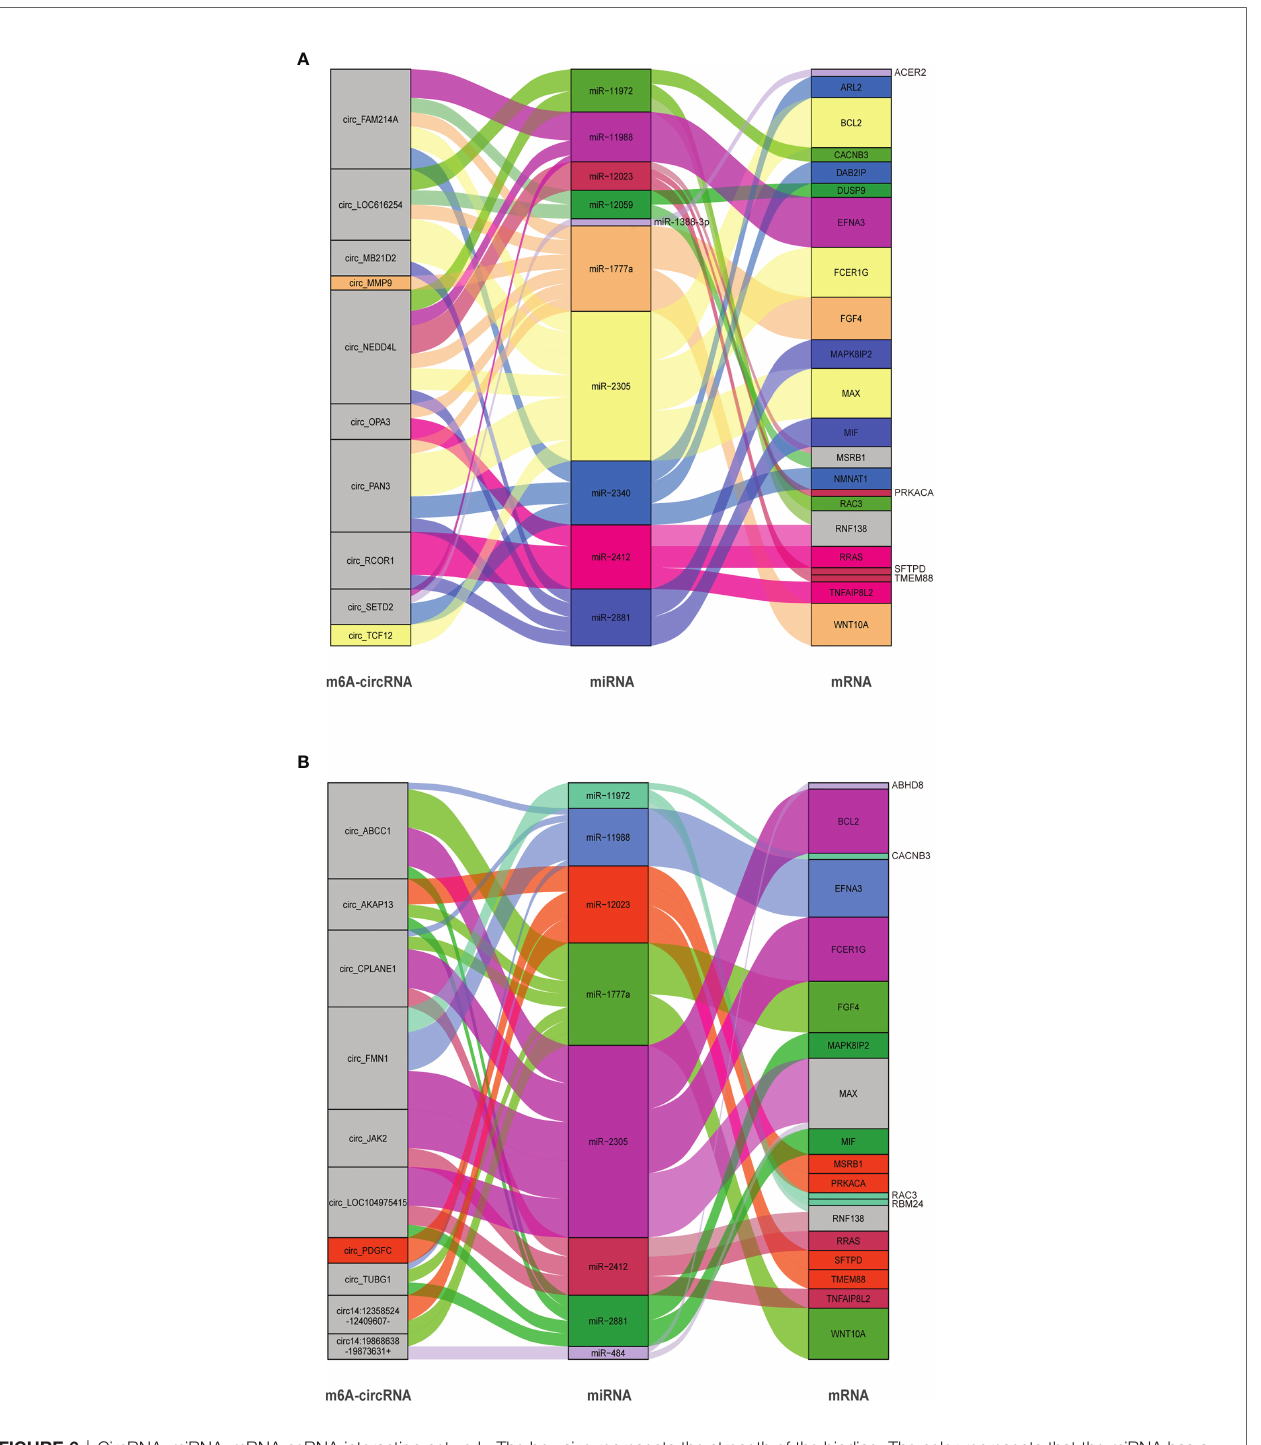
FIGURE 6 | CircRNA – miRNA – mRNA ceRNA interaction network. The box size represents the strength of the binding. The color represents that the miRNA has a binding site with mRNA and circRNA, and if the color is gray, it represents two or more target binding sites. (A) The S. aureus group. (B) The E. coli group (circRNAs were named by their host genes or chromosome